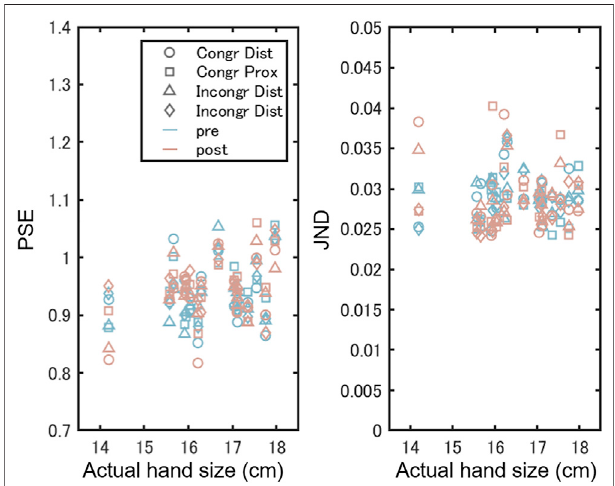
FIGURE 3 | Relation between actual hand size (cm) and point of subjective equality (PSE) and just noticeable difference (JND). A signi fi cant correlation was found only for the PSE ( r (cid:1) 0.32). Congr: congruent, Incongr: incongruent, Dist: distal, Prox: proximal.